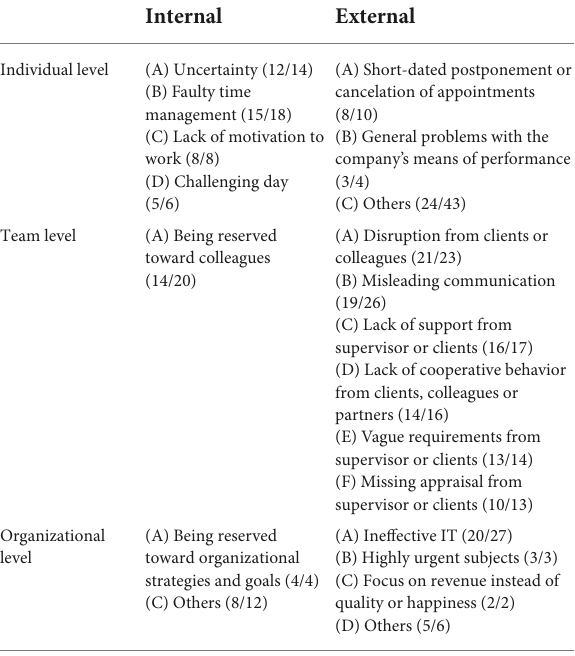
TABLE 1 Internal and external barriers to learning at the individual, team and organizational levels (Anselmann, in press).